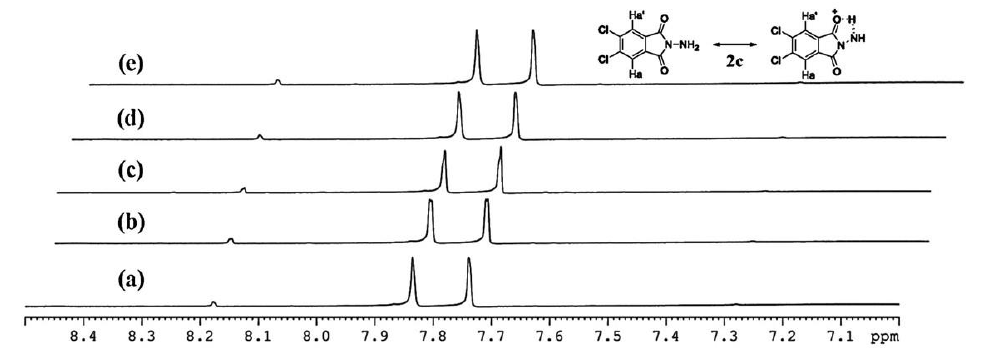
Figure 1. 1 H NMR spectra of N -aminophthalimides 2a , 2c and 2e and phthalazines 1,4-dione 3a and 3e .